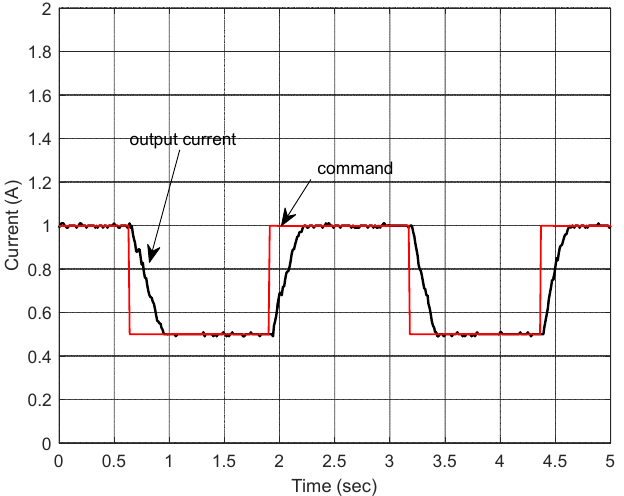
Figure 21. Experimental results for current regulation.